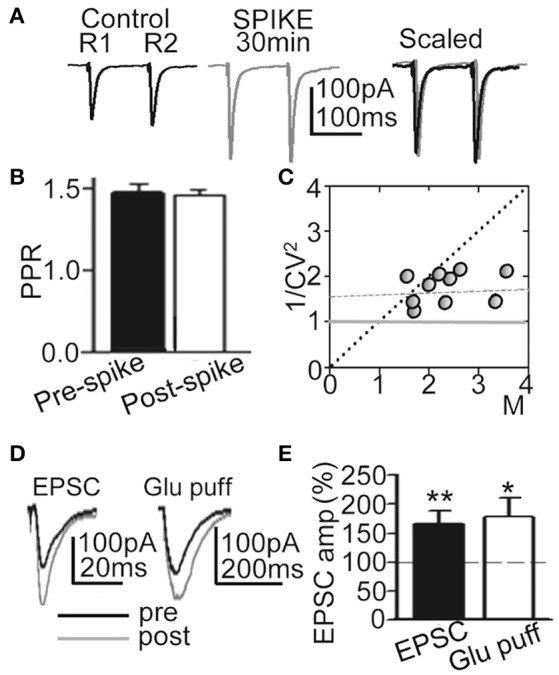
LTP was induced without changes in Glu release probability. (A) Representative averaged EPSCs (n = 20) evoked by paired pulse stimulation (100 ms delay) before (Control R1, R2), at ≈30 min after 60 EPSP-Ca2+ spikes (SPIKE, 30 min) and superimposed and scaled to the amplitude of the first ESPC (Scaled). (B) Summary data showing the unchanged PPR (% of control, N = 15, P > 0.05) before (Pre-spike) and ≈30 min after induction with 60 EPSP-Ca2+ spikes (Post-spike). (C) Plot of the variance (1/CV2) in function of the mean peak EPSC amplitude normalized to controls (M) measured ≈30 min after 60 EPSP-Ca2+ spikes were applied (N = 10). (D) left. Representative superimposed EPSCs recorded before and at ≈30 min after LTP induction. (D) right. Same as left, but currents evoked by Glu puffs. (E) Summary data showing changes in peak EPSC (N = 6, P < 0.01) and Glu puff current amplitudes (same cells, P < 0.05) 30 min after LTP induction, relative to control (100%).